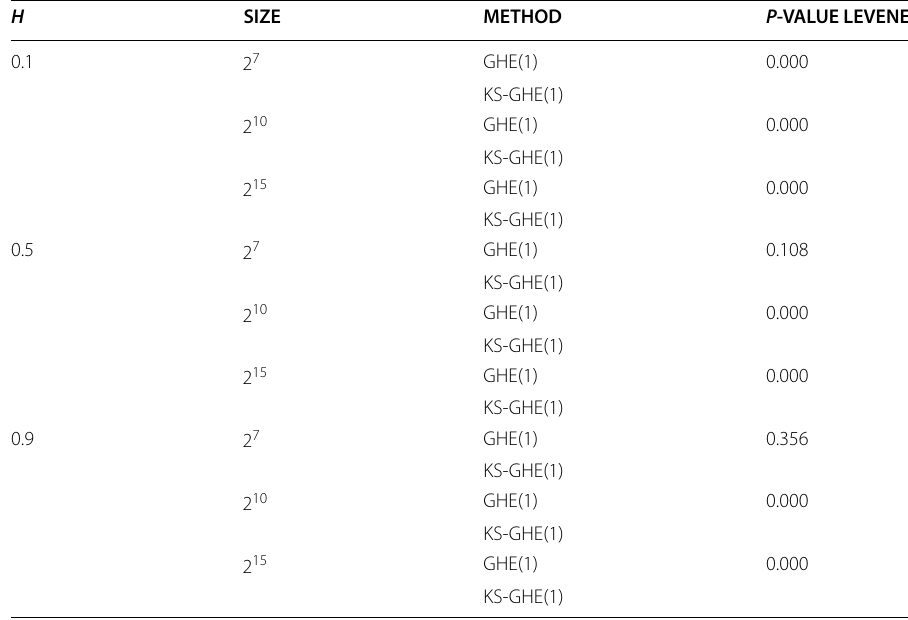
A p ‑value less than 0.01 means that the standard deviations of the two algorithms are significantly different